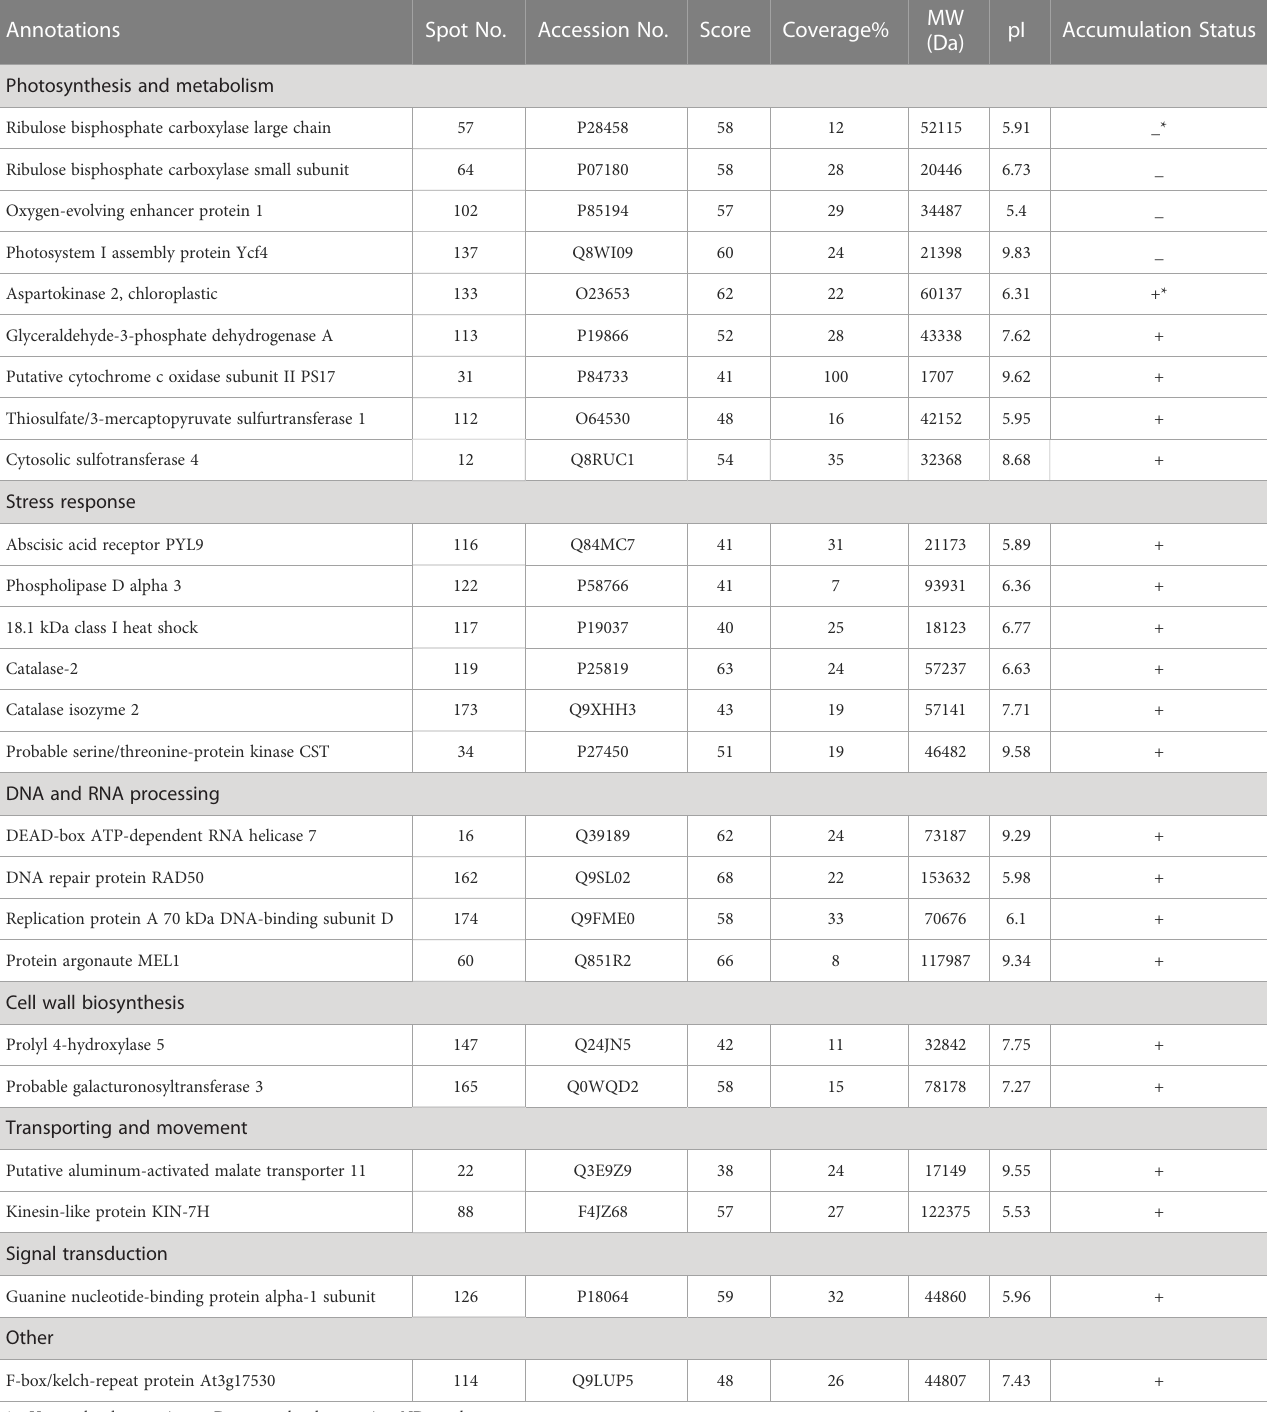
TABLE 2 Protein properties of differentially expressed proteins of pistachio leaves under osmotic stress.